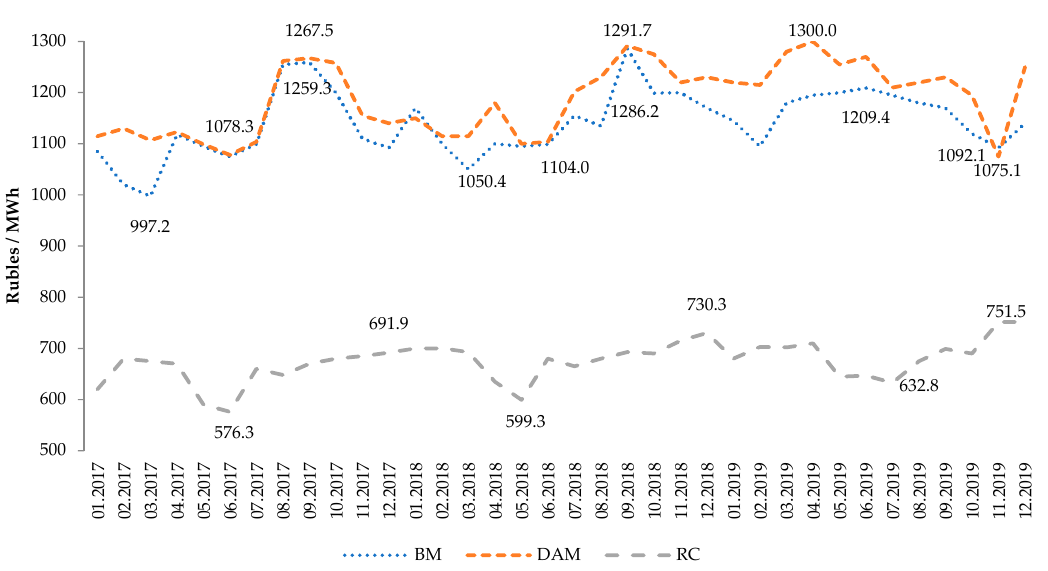
Figure 4. Structure of electricity sales volumes in Russia: the second price zone. Source: own results based on [77].